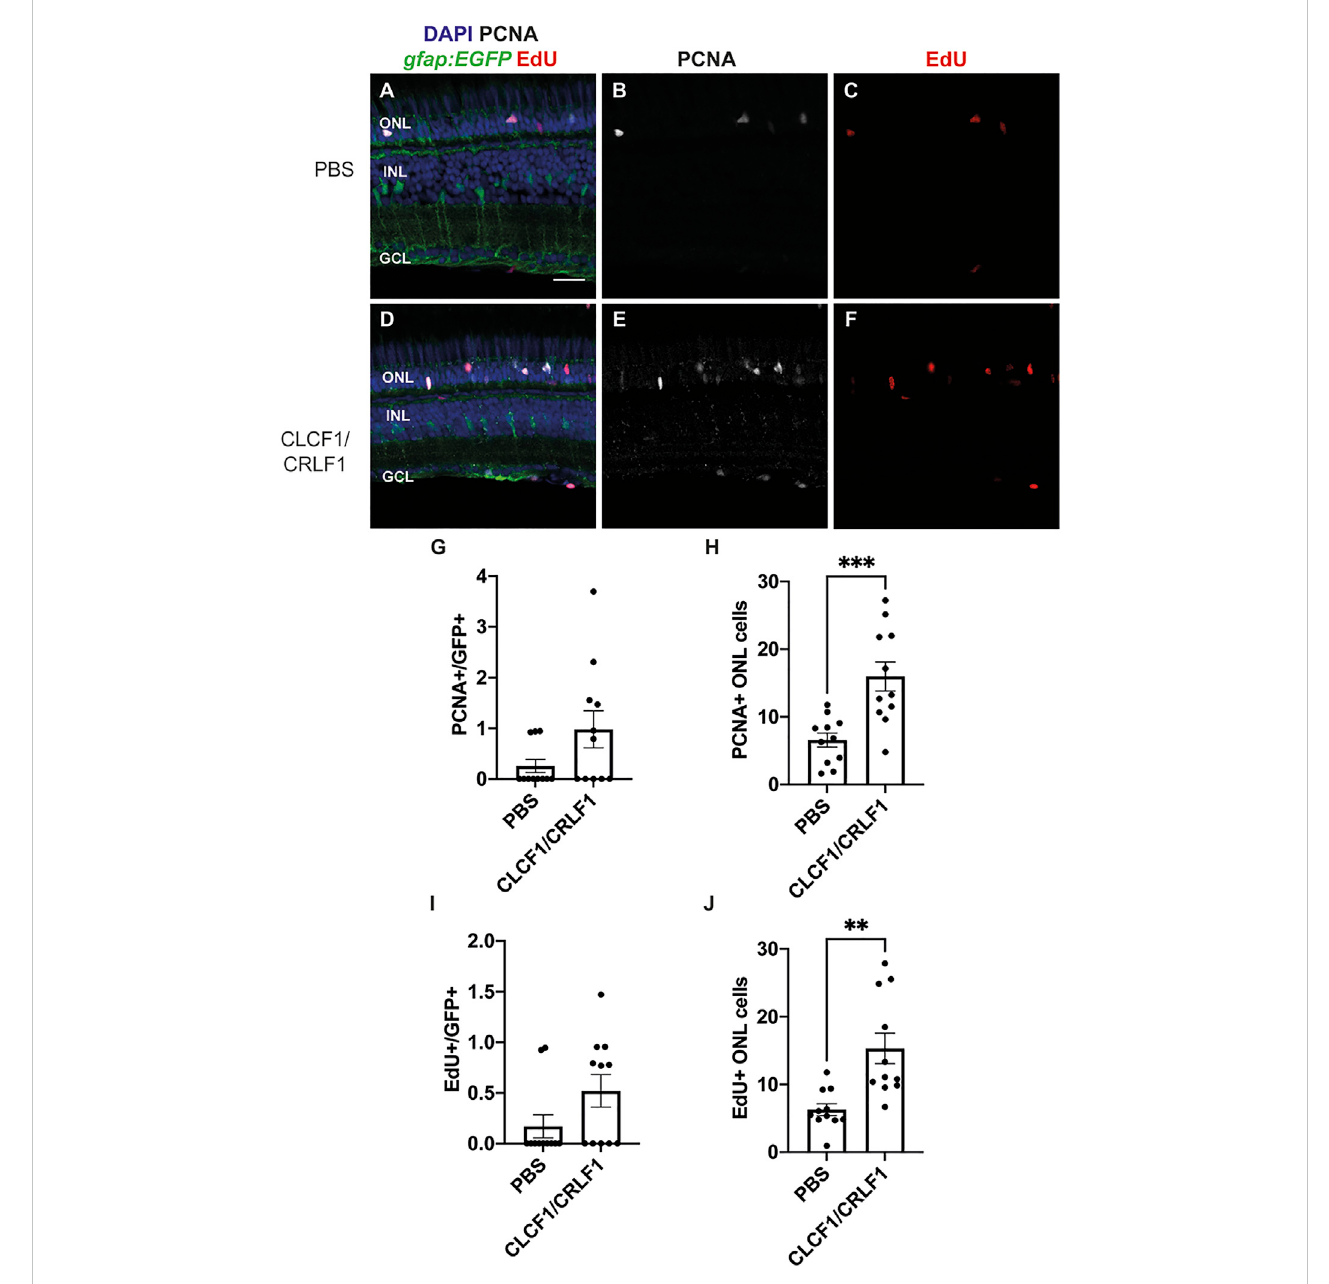
FIGURE 6 Intravitreal injection of recombinant mouse CLCF1/CRLF1 induces rod precursor cell proliferation. (A – F) Single confocal images from albino; Tg[gfap: EGFP] nt11 zebra fi shwhichwereintravitreallyinjectedevery12 hwitheitherPBS (A) orCLCF1/CRLF1 (D) for72 h.SectionswerelabeledforGFP,PCNA,andEdU to assess proliferating Müller glia and nuclei were counterstained with DAPI (B, C, E, F) . (G) Quanti fi cation showing no signi fi cant change in the number of PCNA-positive Müller glia within the INL of CLCF1/CRLF1-injected retinas. Student ’ s t-test, p = 0.08. (H) Quanti fi cation showing signi fi cant increase in the number of PCNA-positive cells within the ONL of CLCF1/CRLF1-injected retinas. Student ’ s t -test, p = 0.0008. (I) Quanti fi cation showing no signi fi cant difference in the number of EdU-positive Müller glia within the INL of CLCF1/CRLF1-injected retinas. Student ’ s t -test, p = 0.09. (J) Quanti fi cation showing signi fi cant increase in the number of EdU-positive cells within the ONL of CLCF1/CRLF1-injected retinas. Student ’ s t -test, p = 0.0014. n ≥ 11. Mean ± SEM, ** p < 0.01, *** p < 0.001. ONL, outer nuclear layer, INL, inner nuclear layer, GCL, ganglion cell layer. Scale bar represents 20